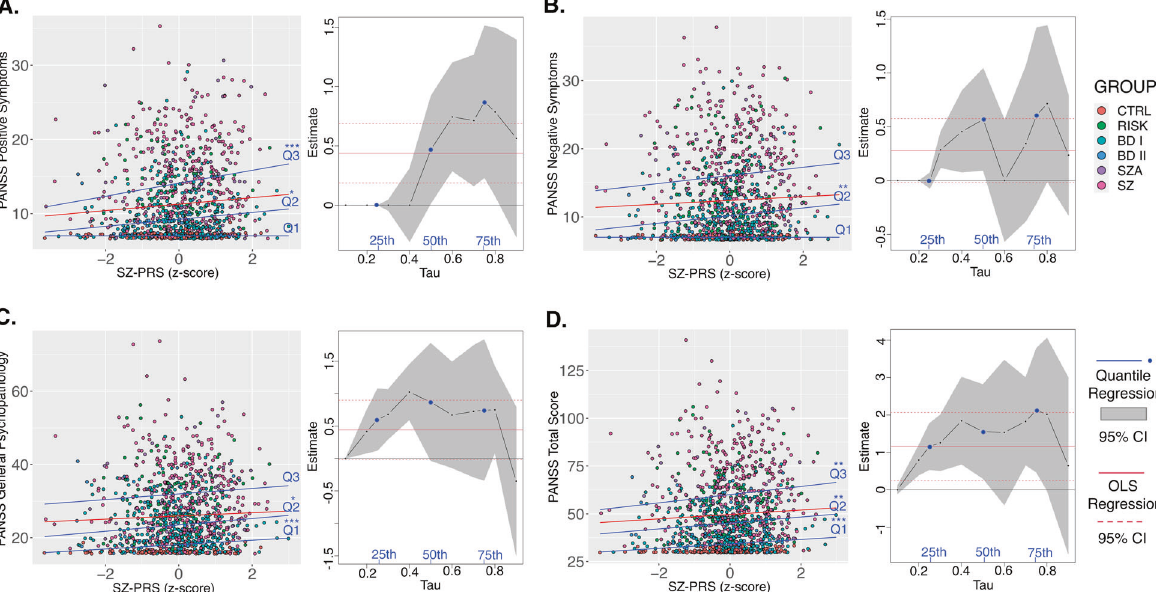
Fig. 3 Quantile regression analysis of schizophrenia polygenic risk score (SZ-PRS) predicting symptoms. Three quantiles of symptom score distributions (Q1 = 0.25, Q2 = 0.50, Q3 = 0.75) included three dimensions ( A – C ) and the total score ( D ) of the Positive and Negative Syndrome Scale (PANSS). The quantile regression estimates are visualized at 0.1 increments as black lines and with corresponding con fi dence intervals (CIs) shown as the gray shaded areas. The Q1, Q2, and Q3 quantiles are depicted in blue. For comparison, the ordinary least squares (OLS) regression estimates are shown as red solid lines with their CIs as dashed red lines. Many quantile estimates fell within the CI of the OLS regression slope, indicating overlap (though OLS does not adequately address the fl oor effect). * p < 0.05; ** p < 0.01; *** p < 0.001. There were no signi fi cant results for BD-PRS. Group abbreviations: BD I bipolar I disorder, BD II bipolar II disorder, CTRL controls, RISK at-risk state for psychosis, SCHIZ L lower schizotypy, SCHIZ H higher schizotypy, SZA schizoaffective disorder, SZ